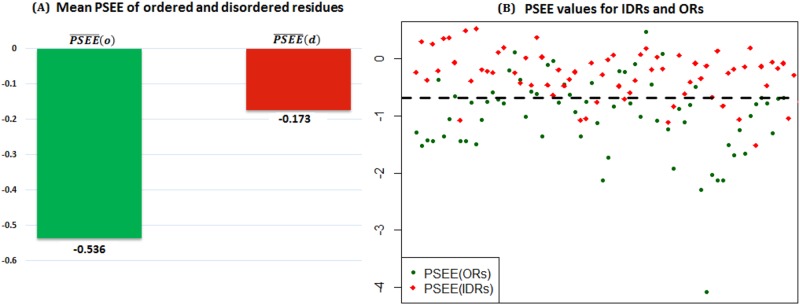
Order versus disorder characterization of PSEE both in residue and region level.(A) Mean PSEE for ordered (green bar) and disordered (red bar) residues of DisProt680 dataset. The bars are label with the respective mean PSEE values. (B) PSEE values for ordered regions (green circle) and disordered regions (red diamond). The separation threshold between the average PSEE of all ordered and disordered region is indicated by black dashed line. The x-axis and y-axis represent the region index and the corresponding PSEE values.